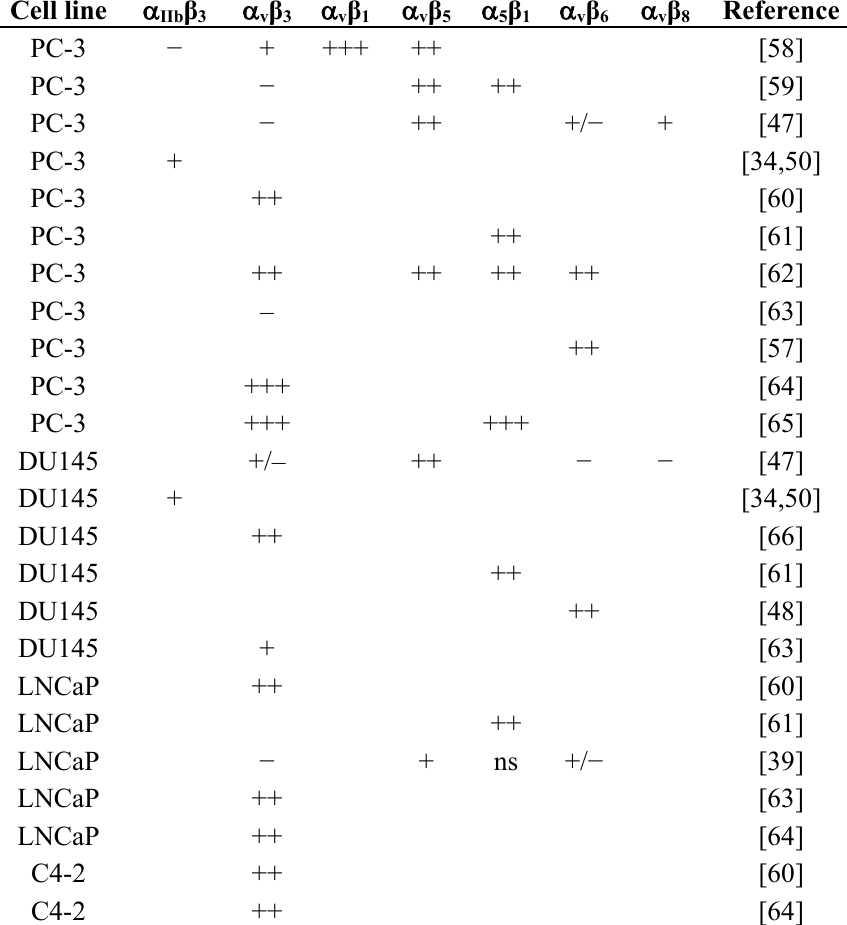
Table 3. RGD-binding integrin heterodimer expression on the surface of prostate cancer cell lines. Key: +++ very high; ++ high; + moderate; +/− low; − negative; blank not tested; ns expressed but level not